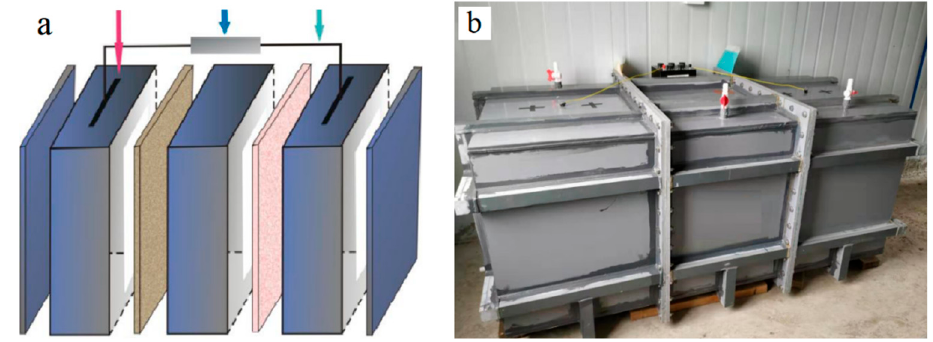
Figure 1. Schematic diagram of aircathode microbial desalination cell ( a ) and physical photo ( b ).